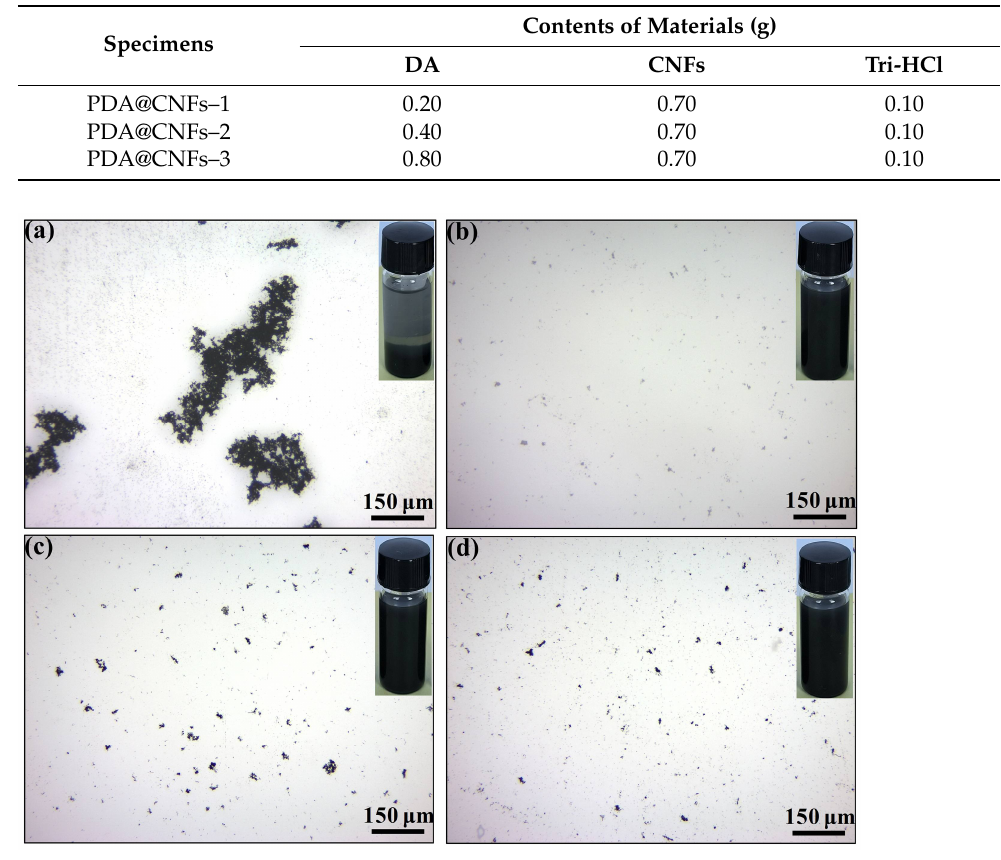
Figure 2. Optical microscope and macroscopic image of nanofillers dispersing in ethanol solution after 10 min ultrasonic and setting for 10 days. ( a ) CNFs, ( b ) PDA@CNFs–1, ( c ) PDA@CNFs–2, ( d )